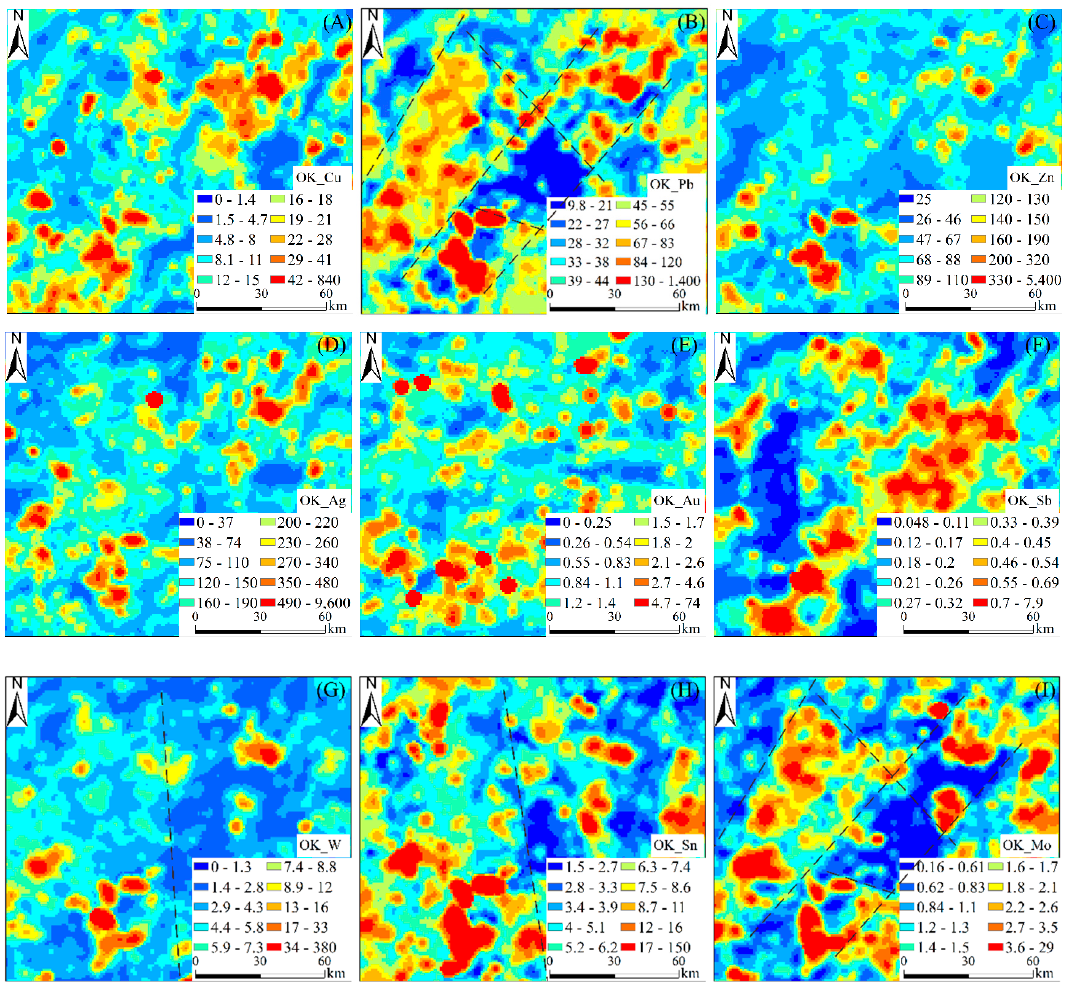
Figure 4. Maps showing the spatial distributions of interpolated geochemical elements using OK. ( A ) Cu, ( B ) Pb, ( C ) Zn, ( D ) Ag, ( E ) Au, ( F ) Sb, ( G ) W, ( H ) Sn, ( I ) Mo.